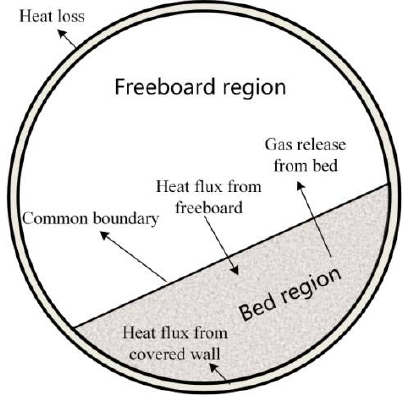
Figure 2. Heat and mass transfer between freeboard region and bed region.